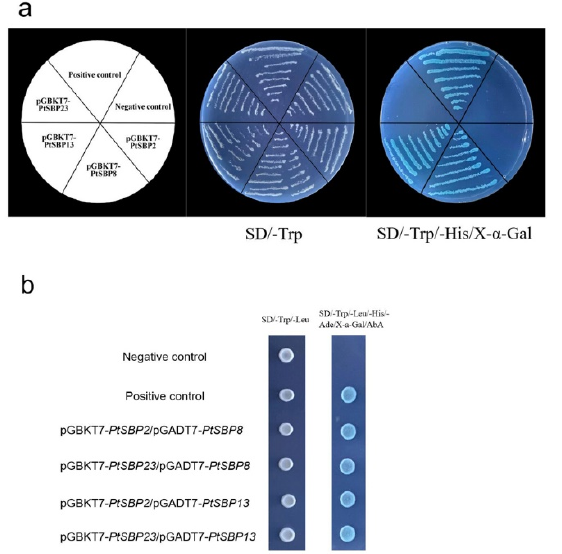
Figure 11. Self-activation activity analysis and yeast two-hybrid experiment. ( a ) Self-activation test of PtSBP2 , PtSBP8 , PtSBP13 and PtSBP23, setting pGBKT7as negative contrast and pGBKT7-53/pGADT7-T as positive contrast. ( b ) Interaction experiment of PtSBP protein of yeast two-hybrid, setting pGBKT7Lam/pGADT7-T as negative contrast and pGBKT7-53/pGADT7-T as positive contrast.